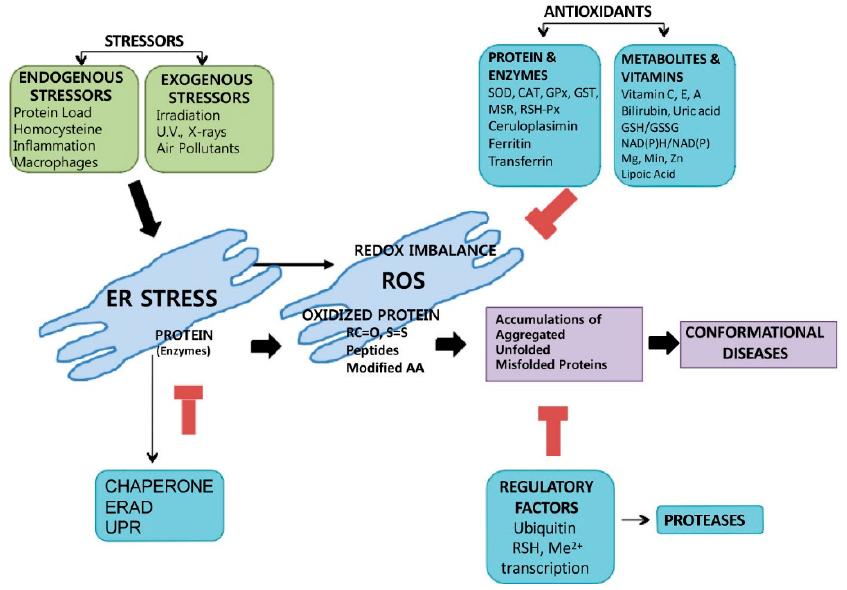
Figure 2. Aggregation of oxidized proteins depends on the balance of redox signaling mediators, anti-oxidants, pro oxidants, and proteolytic activities in the ER. In the presence of stressors, redox imbalance causes a protein load that leads to ER stress. Then, accumulation of oxidized proteins causes the aggregation, misfolding, or unfolding of proteins and thus the occurrence of conformational diseases. SOD, superoxide dismutase; CAT, catalase; GPx, glutathione peroxidase; GST, glutathione transferase; MSR, methionine sulfoxide reductase; RSH-Px, thiole specific peroxidase. The black arrows are showing the stimulation or the flow of mechanism, while red/T-like arrows are showing the blocking of the process.